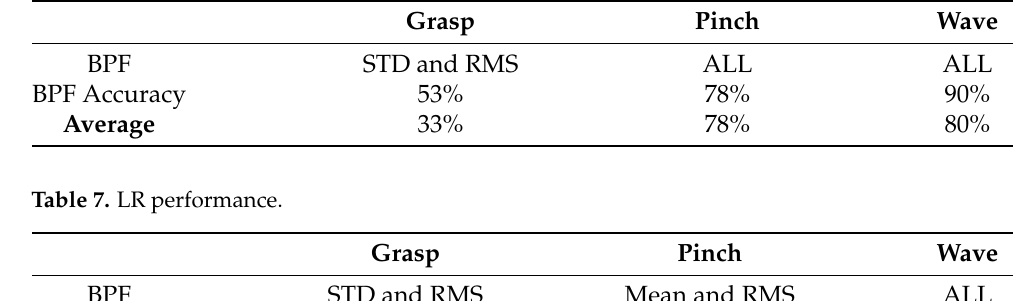
Table 6. XGBoost performance.